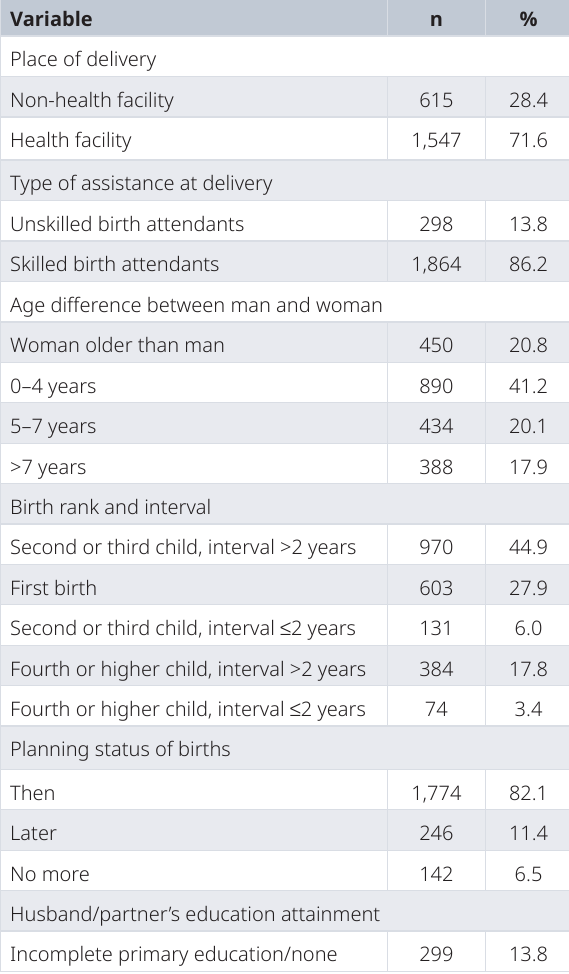
Table 1. Characteristics of the respondents regarding determinants of safe delivery utilization among Indonesian women in eastern part of Indonesia